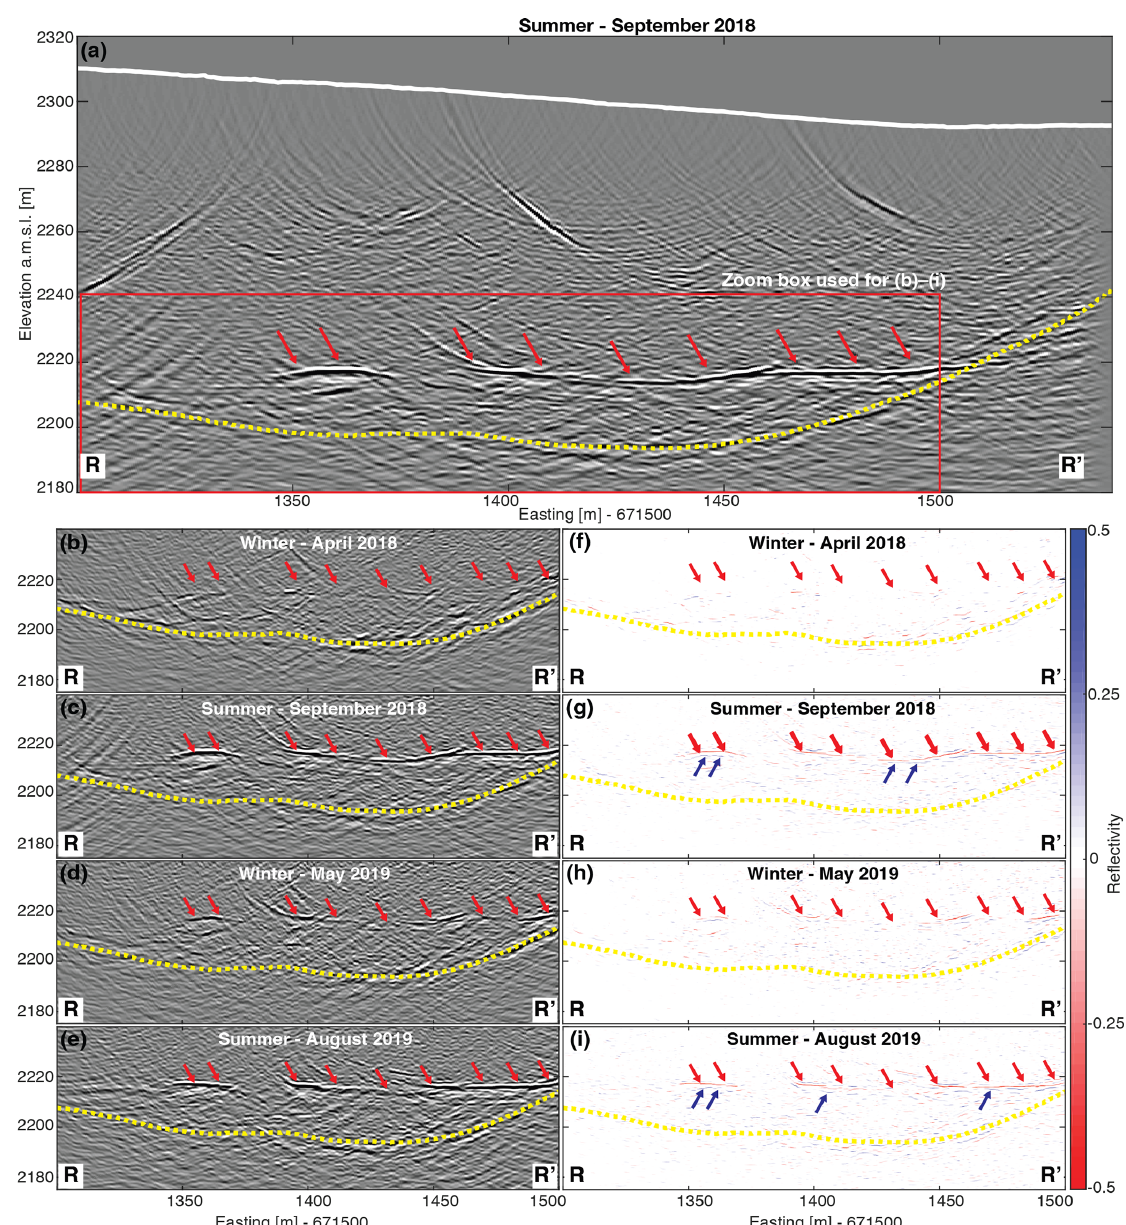
Figure 3. (a) Seasonal GPR imaging results over a single repeated GPR profile (R-R (cid:48) in Fig. 1) in 2018. The yellow line represents the ice– bedrock interface, the white line represents the glacier surface, and the red box is the zoom box for GPR imaging and reflectivity results (b–i) . Panels (b) – (e) are seasonal GPR imaging results, and (f) – (i) are the seasonal GPR reflectivity results from (b) – (e) . The red arrows represent the top of the englacial conduit network, and the blue arrows represent the bottom of the englacial conduit network (g, i)